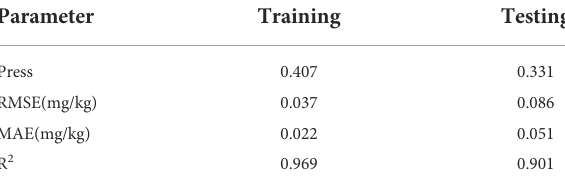
TABLE 4 Detection results of the method proposed in this study.